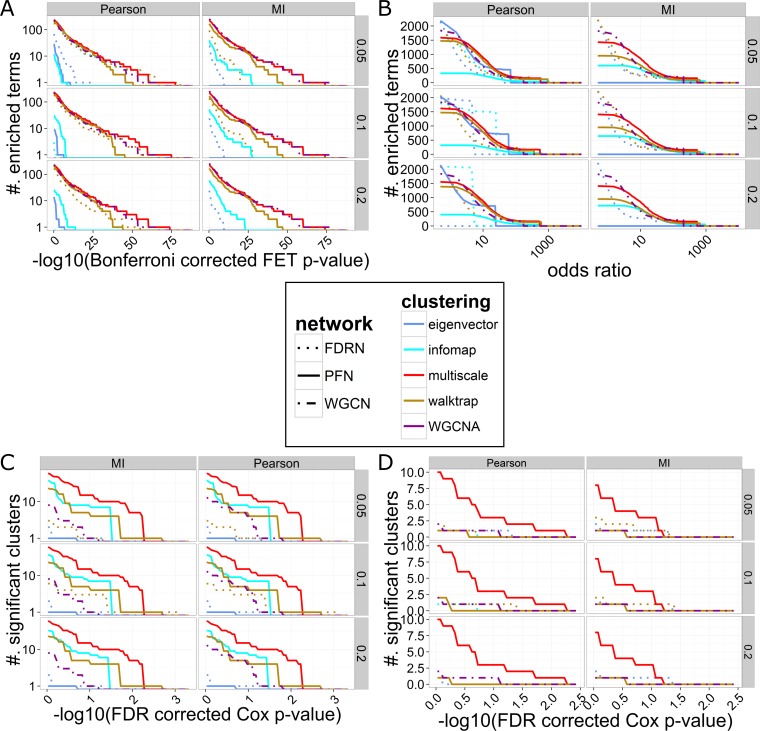
Comparison of MEGENA (as a combination of the multiscale clustering analysis and PFN) and various combinations of the established clustering techniques (eigenvector, infomap, walktrap, WGCNA) and the networks (PFN, FDRN, WGCN) using the TCGA BRCA gene expression data.Two different similarity measures (MI and PCC) were used to perform analyses to compare robustness with respect to difference in measures to evaluate interactions. A) The number of significantly enriched functional/pathway signatures (Bonferroni corrected FET p-values) from MSigDB at various p-value thresholds against. B) Number of significantly enriched functional/pathway signatures from MSigDB at the various odds ratio thresholds. C) Number of clusters predictive of patient survival (based on FDR corrected Cox p-values) at various significance levels. D) Number of clusters predictive of patient survival (based on FDR corrected Cox p-values) and associated to at least one significantly under-represented signatures with Bonferroni corrected FET p-value < 0.05.